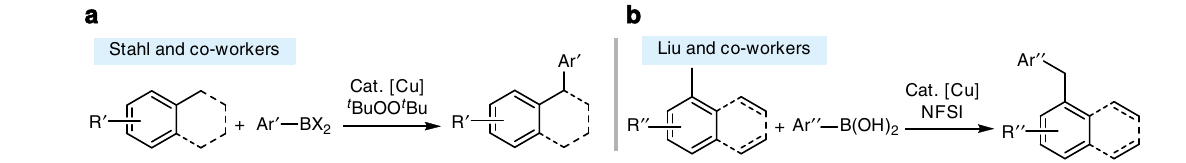
Fig. 1 Copper-catalyzed arylations of toluene derivatives. a Cu-catalyzed oxidative arylation with di- tert -butyl peroxide. b Cu-catalyzed arylation with N - fl uorobenzenesulfonamide